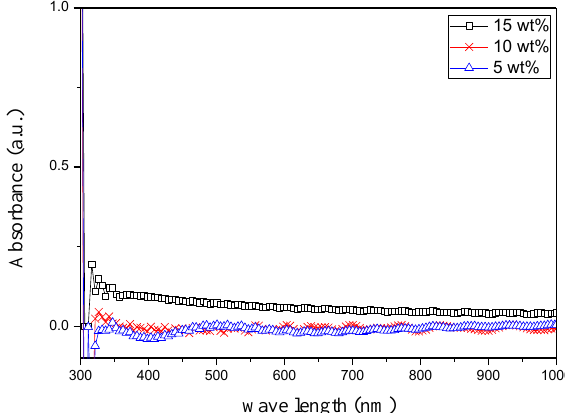
Figure 6. The UV-Vis analysis of PVDF film with different PVDF concentrations.